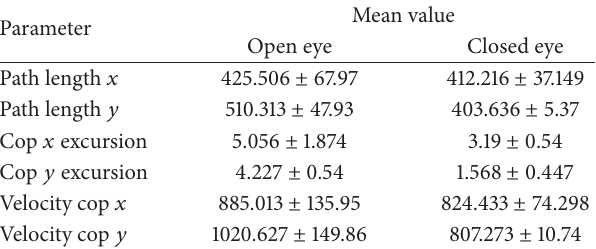
Table 4: The mean value of stability parameters of the participant under eyes opened and closed